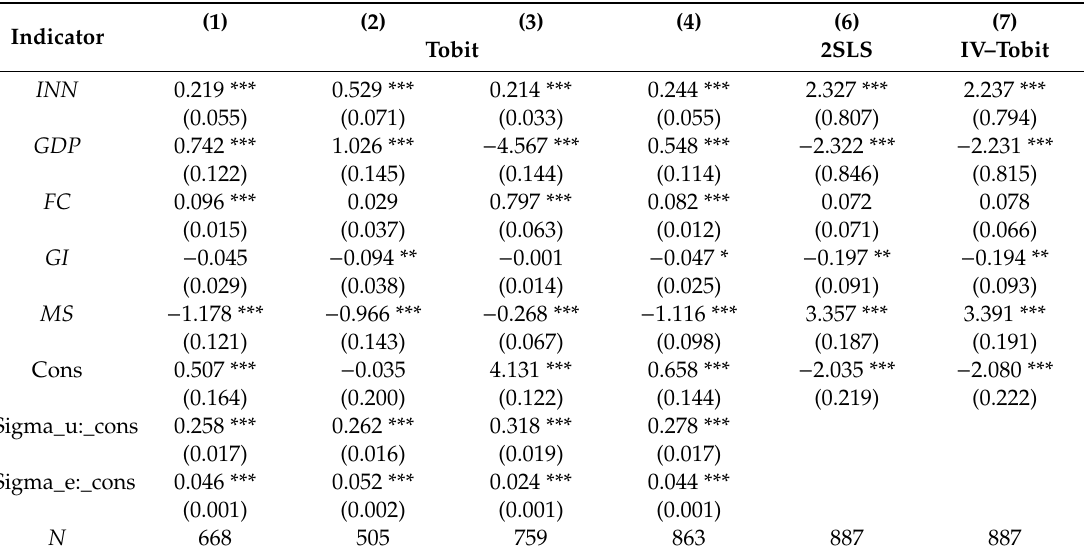
Table 4. Regression results of robustness and endogeneity